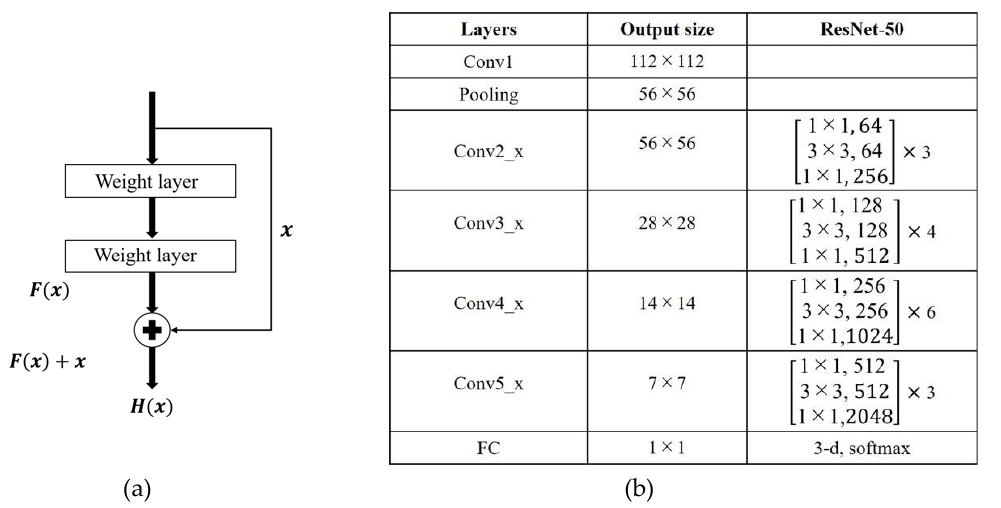
Figure 4. ResNet50 network. (a) Shortcut connection and (b) network structure.